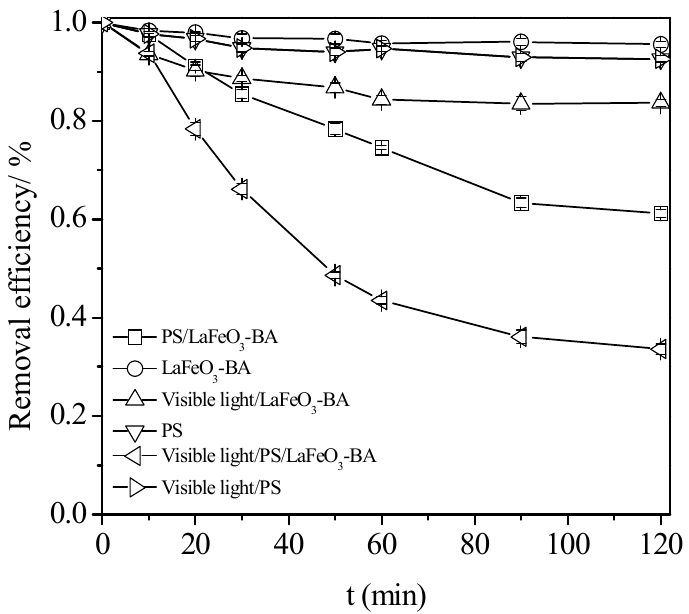
Figure 4. Process combination effect on the tetracycline degradation. Conditions: C 0 = 100 mg L − 1 , [BA] = 0.5 g L − 1 , [PS] = 50 mM, and pH 0 = 3.7.